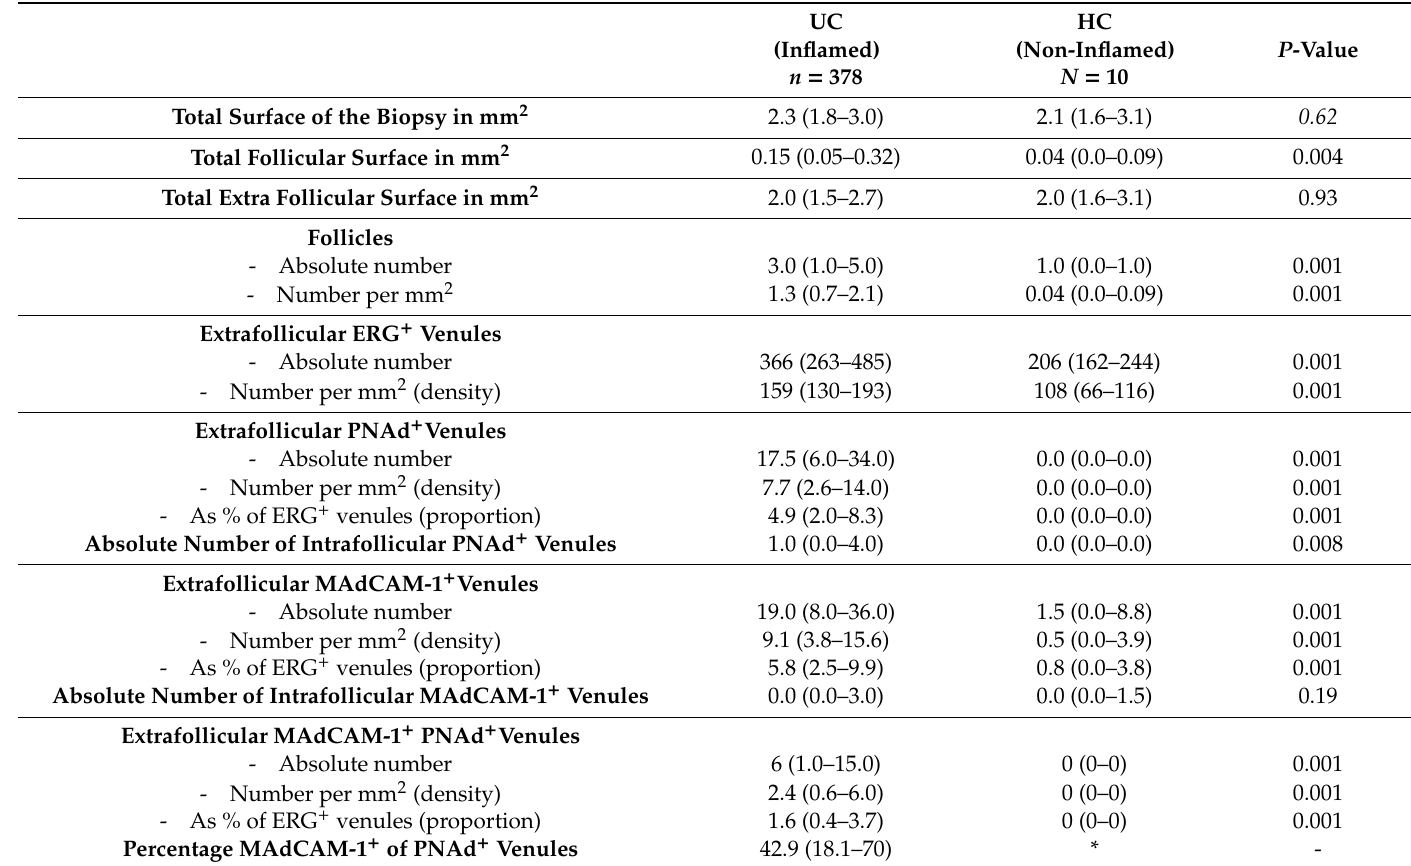
Table 2. The presence of follicles and extrafollicular PNAd + , MAdCAM-1 + and / or ERG + venules in the inflamed colonic biopsies at UC diagnosis compared to healthy